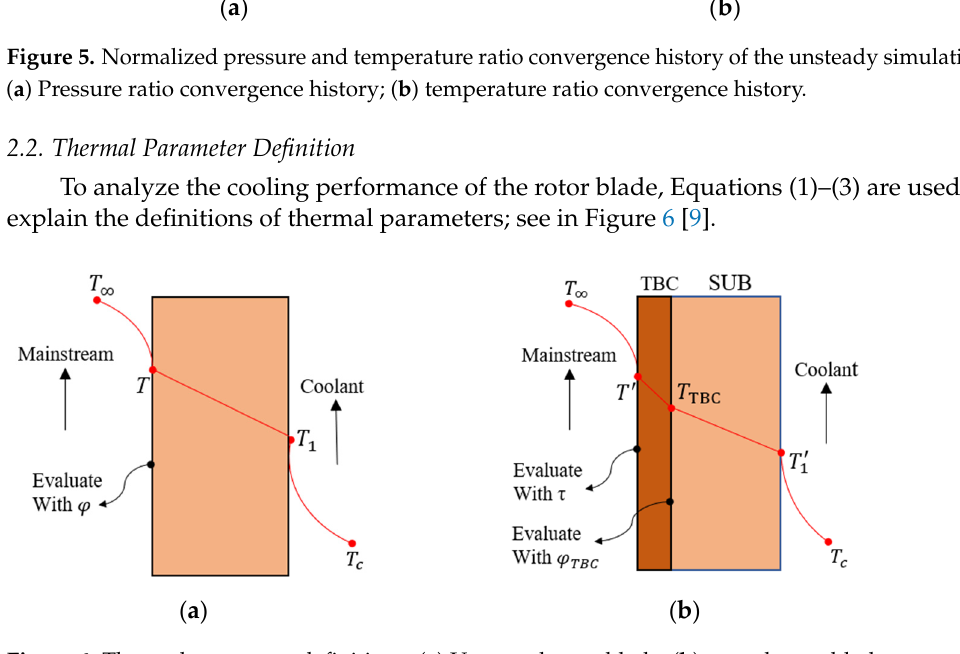
Figure 6. Thermal parameter definitions. ( a ) Uncoated rotor blade; ( b ) coated rotor blade.